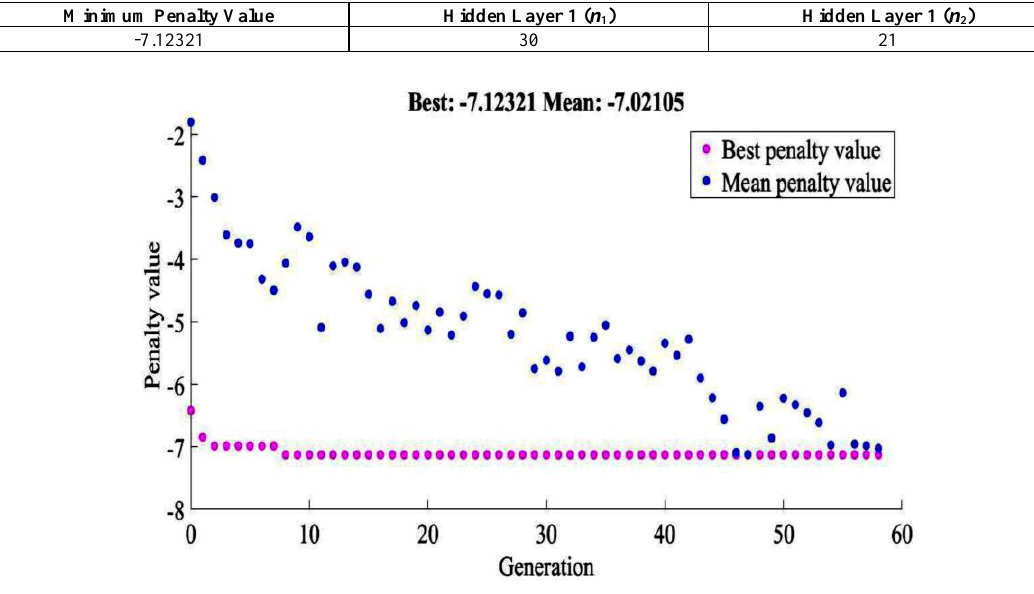
Figure 7. Penalty value versus